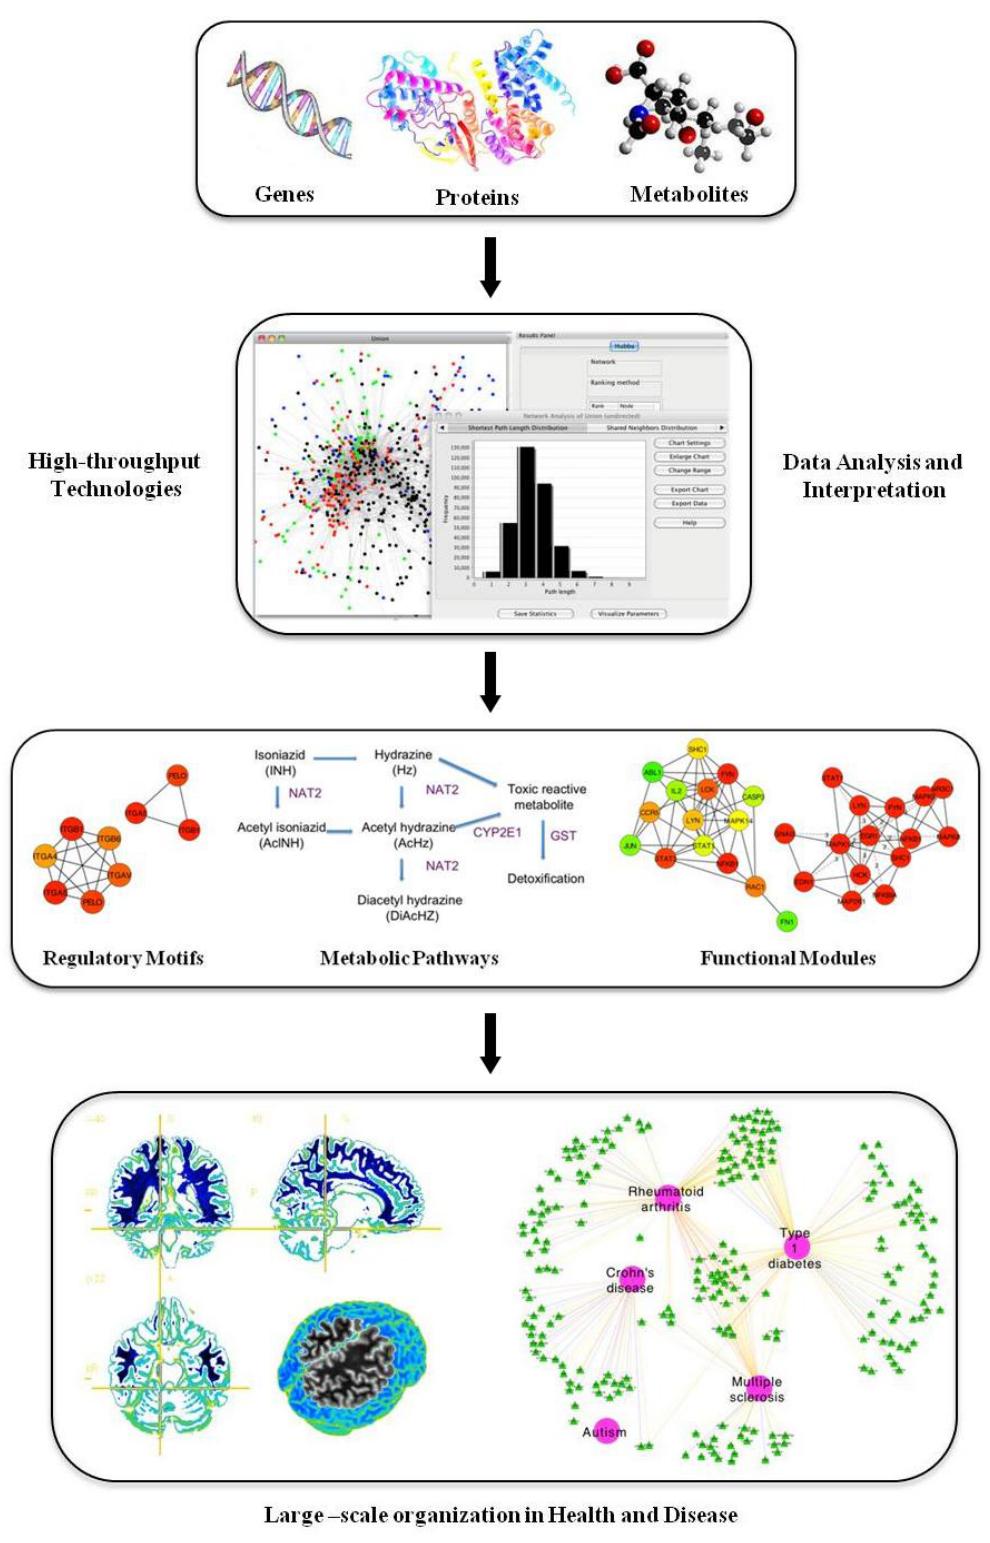
Figure 1. Scheme of a systems biology